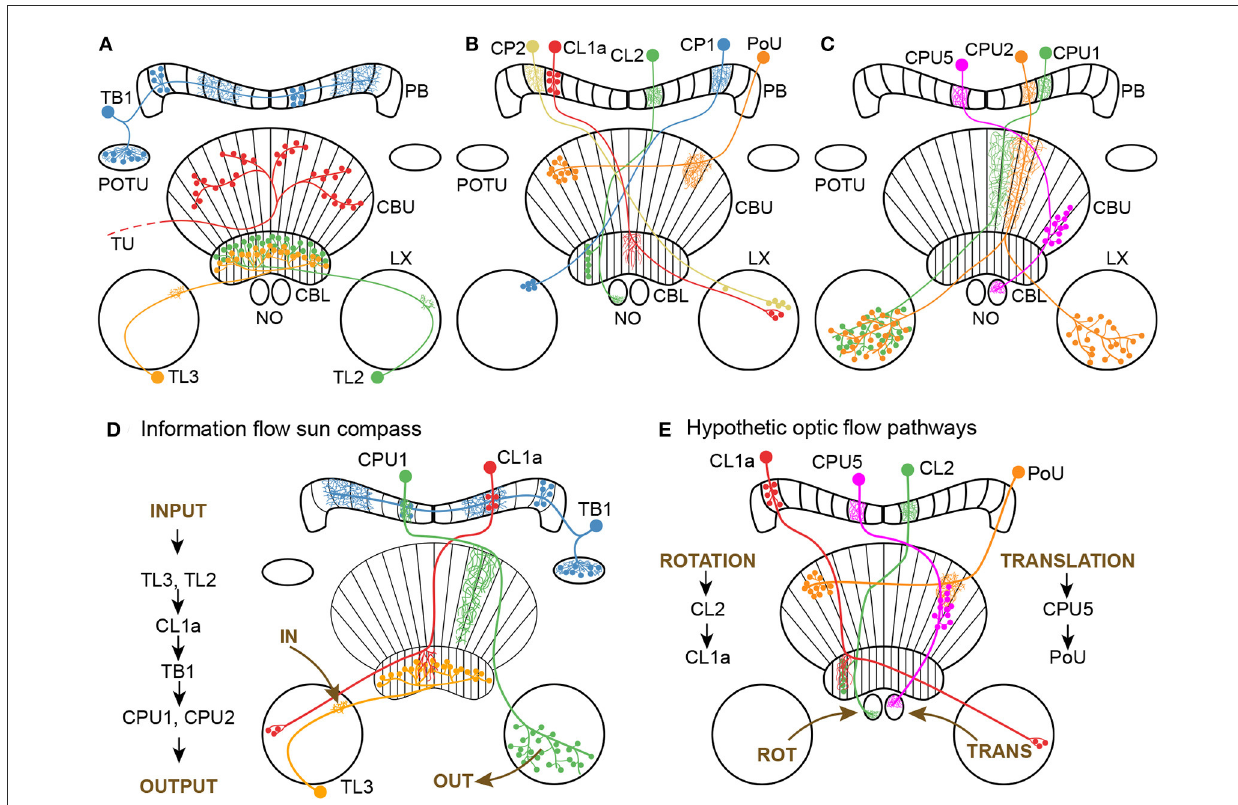
FIGURE1 Morphology of neuron classes analyzed in this study. (A–C) Schematics of the locust central complex and associated neuropils (CBL, lower division of the central body; CBU, upper division of the central body; LX, lateral complex; NO, noduli; PB, protocerebral bridge; POTU, posterior optic tubercle) with individual neurons from different classes superimposed. Large dots indicate somata, small dots indicate axonal (presynaptic) arborizations, and fine lines indicate dendritic (postsynaptic) arborizations. (A) Tangential neurons. We classified TU neurons as a group of diverse neurons that only have in common that they have large presynaptic arborizations in the CBU and input regions outside the central complex. Wiring schematics based on von Hadeln et al. (2020). (B, C) Columnar neurons. Wiring schematics based on Heinze and Homberg (2008). (D) Information flow through core neuronal elements of the sun compass circuit in the locust central complex, based on Heinze and Homberg (2007) and Heinze et al. (2009). For reasons of simplicity TL2 and CPU2 neurons are not included in the diagram. (E) Hypothetic neuronal cell types shown in A-C and their putative connectivity, that might be involved in optic flow signaling. Data are based on corresponding cell types in the fly Drosophila (Green et al., 2017; Turner-Evans et al., 2017; Lu et al., 2022) and the sweat bee Megalopta genalis (Stone et al.,